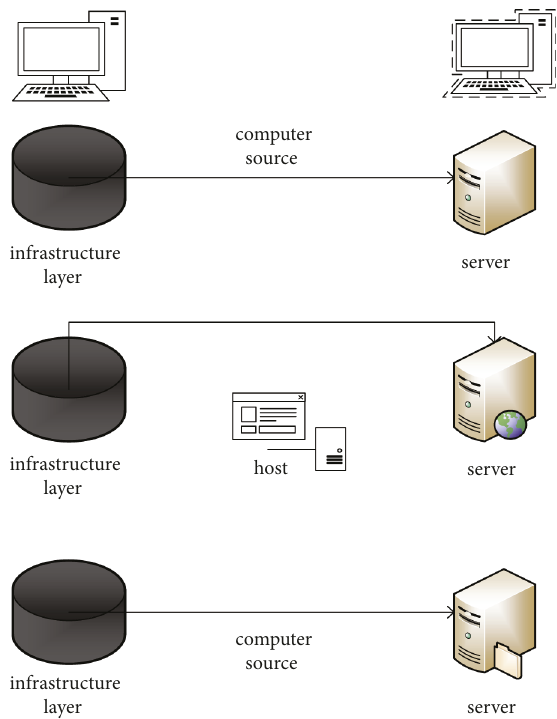
Figure 1: Network architecture based on deep neural network